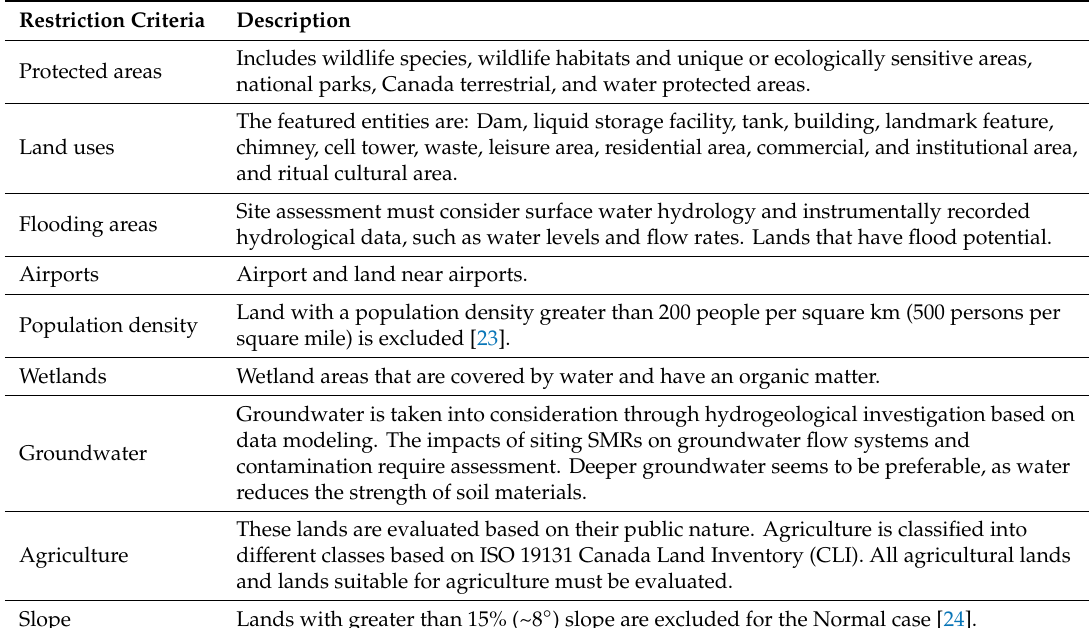
Table 1. Restriction criteria for SMR site selection in Saskatchewan [7,19–21].